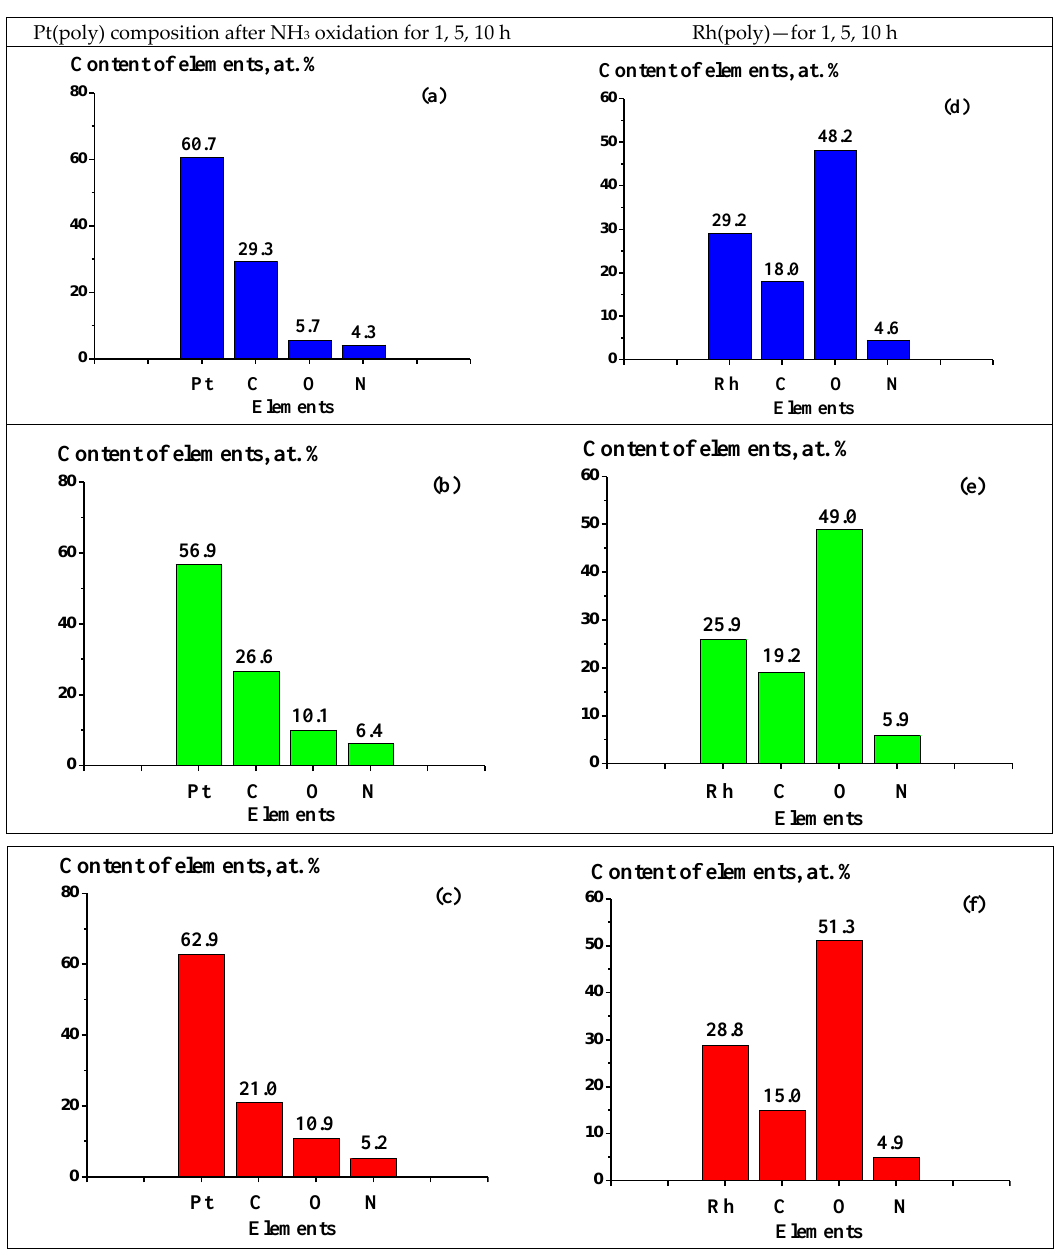
Figure 5. Concentrations of Pt, Rh and C, O, N on Pt(poly) ( a – c ) and Rh(poly) ( d – f ) after NH 3 oxidation at 1133 K for 1 ( a , d ), 5 ( b , e ) and 10 ( c , f ) hours according to EDS data obtained at a probe electron energy E 0 = 20 keV.